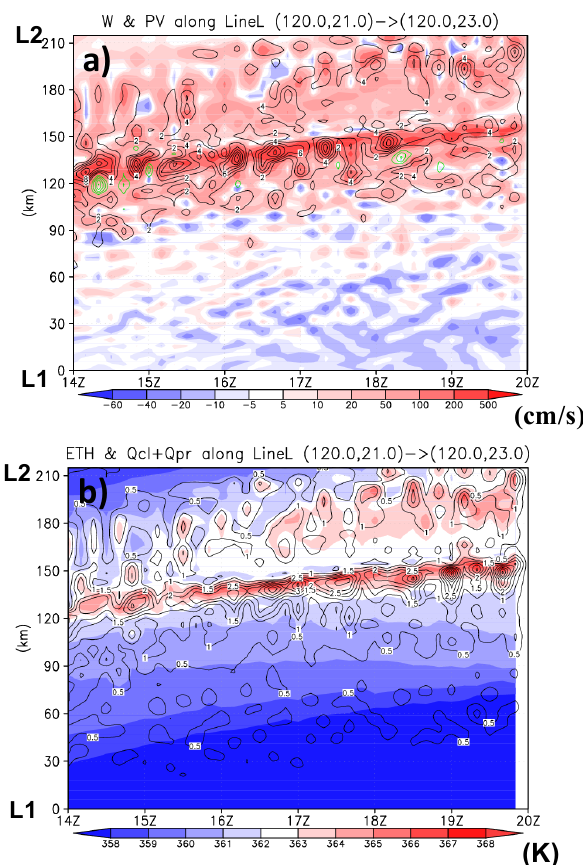
Fig. 13. Simulated results of the temporal variation along cross- section line L1–L2 in Fig. 10b from 14:00UTC to 20:00UTC 7 August. (a) vertical velocity fields (colored shades: positive in red and negative in blue) and potential vorticity (contours: positive in black and negative in green, interval: 2PVU) (b) same as (a) but for theata-e and total precipitation mixing